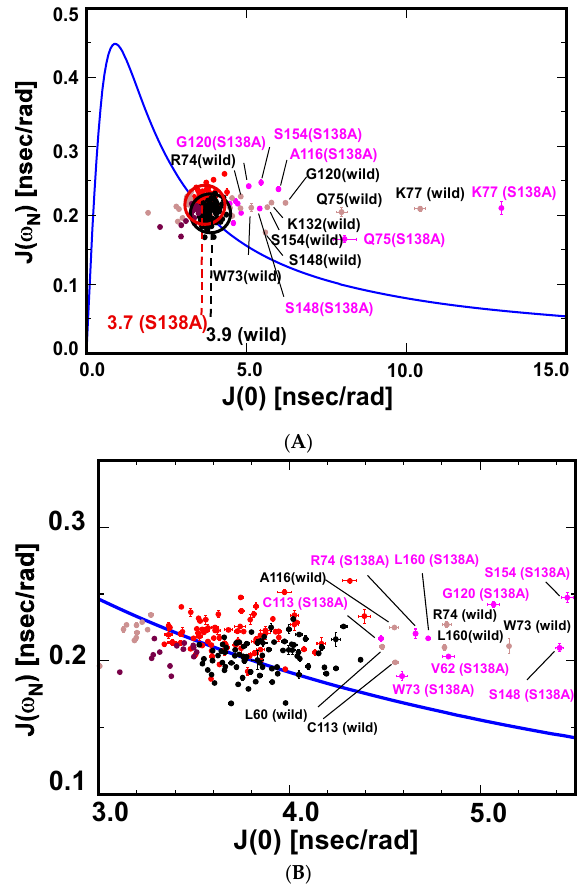
Figure 4. Graphical correlations between J (0) and J ( ω N ) for the wild-type Pin1-PPIase and S138A mutant. ( A ) The simple correlation represented by Equation (1) is shown by the blue curve. The experimentally obtained J (0)– J ( ω N ) correlations for residues in the wild-type Pin1-PPIase and S138A mutant are plotted. Residues with J (0) values within the average J (0) ± 0.5 σ for the wild-type and S138A mutant are colored black and red, respectively. Residues with J (0) values outside the above range for the wild-type and S138A mutant are colored light brown and purple, respectively; ( B ) An expanded view of the clustered data points in (A).